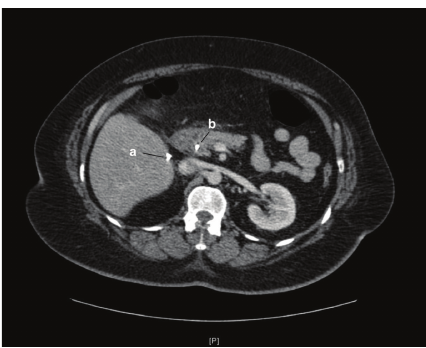
Figure 1: CT abdomen demonstrating (a) hyperdense material corresponding to surgical clip(s) in gallbladder fossa and (b) hyper- dense material in the distal CBD.